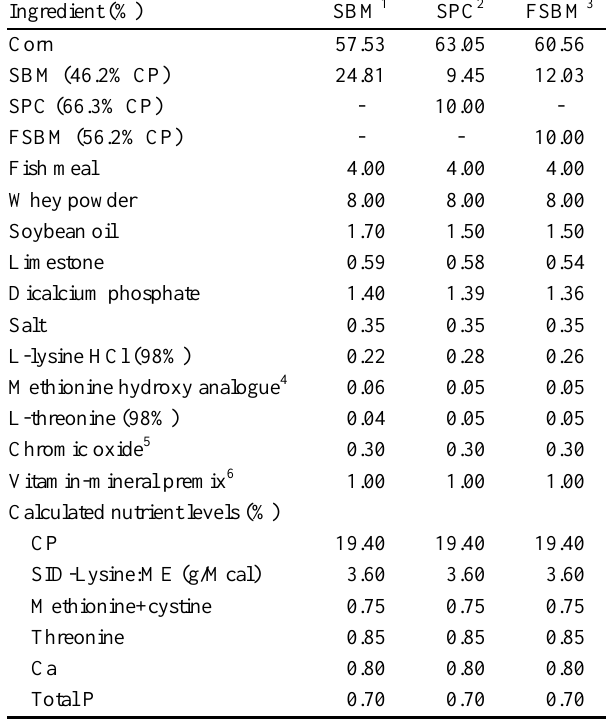
Table 4. Ingredient composition of experimental diets containing soybean meal (SBM), soy protein concentrate (SPC)